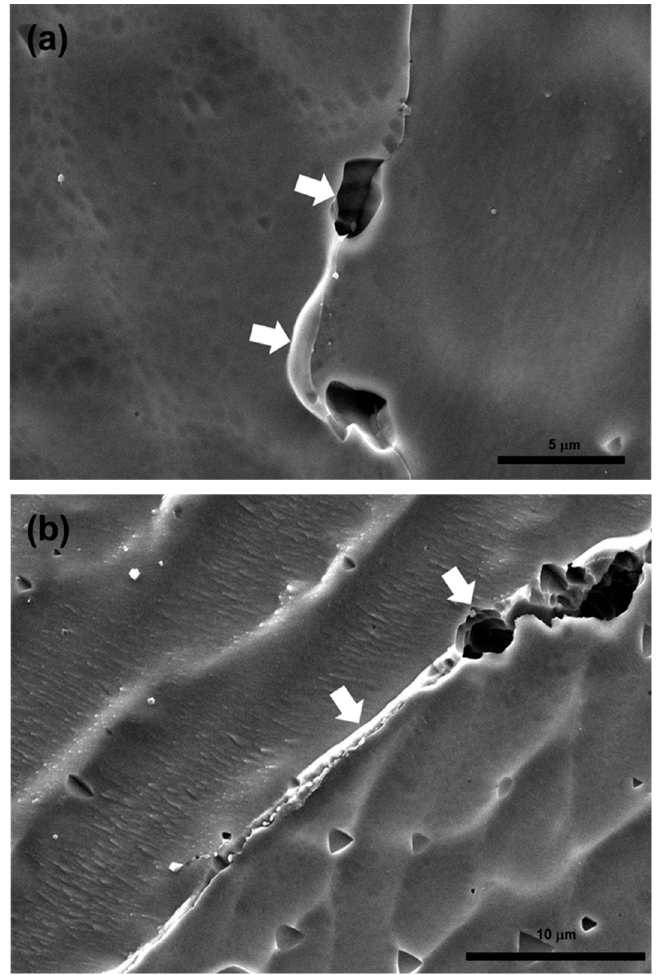
Figure 8. ( a ) Intergranular liquid film penetrating the voids; ( b ) precipitate and liquidation cracks in the WM.